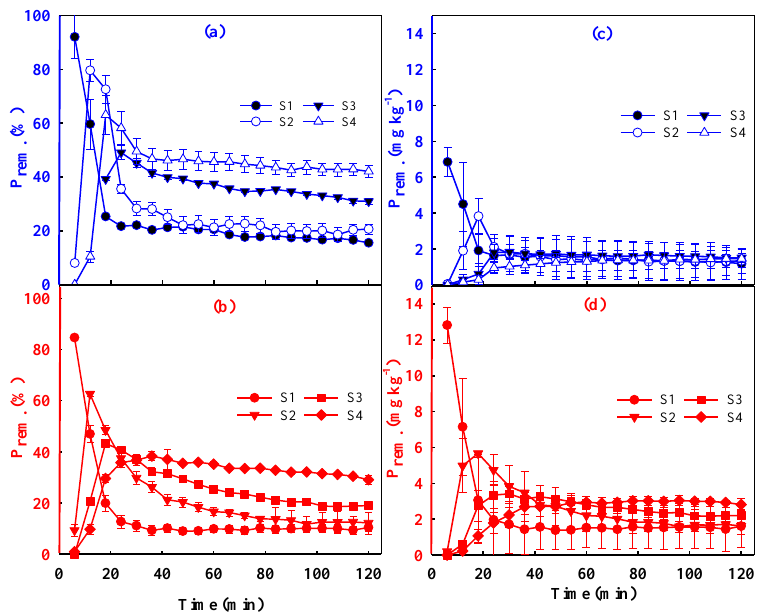
Figure 3. Discrete phosphorus (P) removal with time, among each slag segment during the 2 h flow-through test, expressed as both mg P removed kg − 1 slag ( c , d ) and percentage ( a , b ). Figures ( a , c ) are for the inflow P treatment of 2.5 mg L − 1 , while ( b , d ) are 5.0 mg L − 1 .